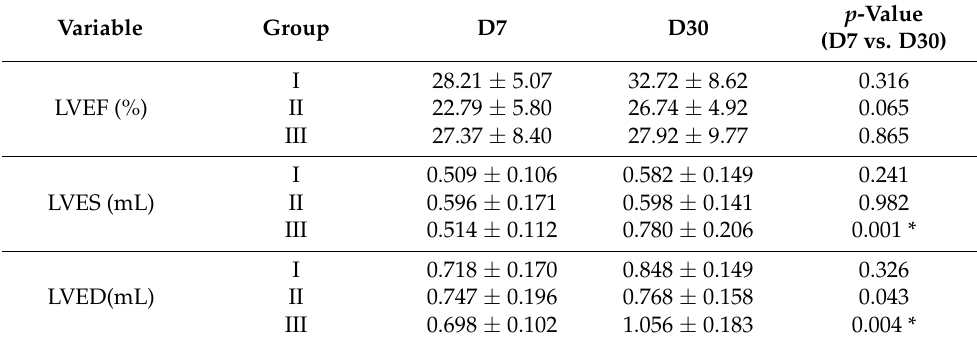
Table 1. Echocardiographic results in the three groups at two time-points.